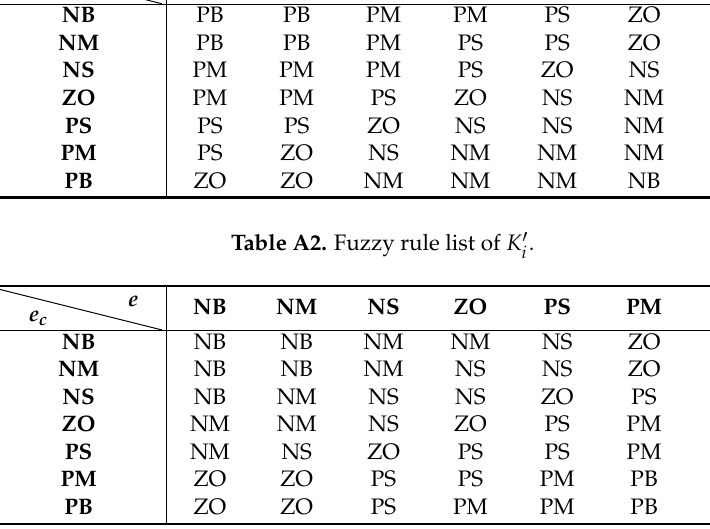
Table A3. Fuzzy rule list of K (cid:48)